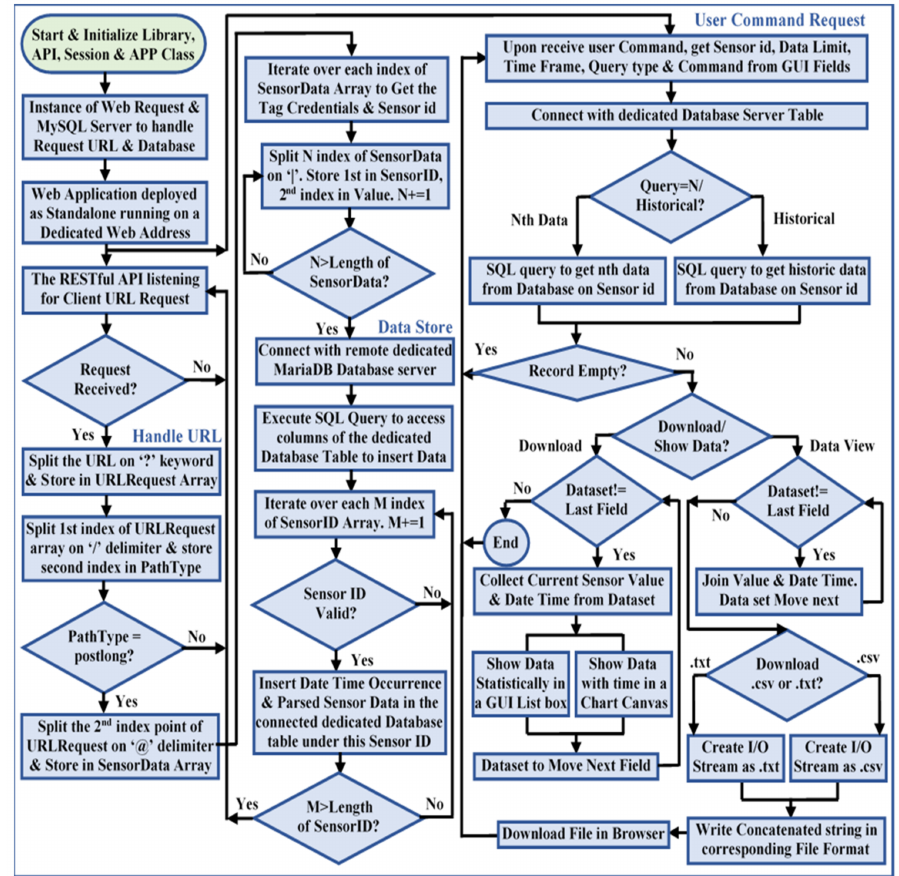
Figure 11. Process flow chart of the ThingsSentral TM cloud